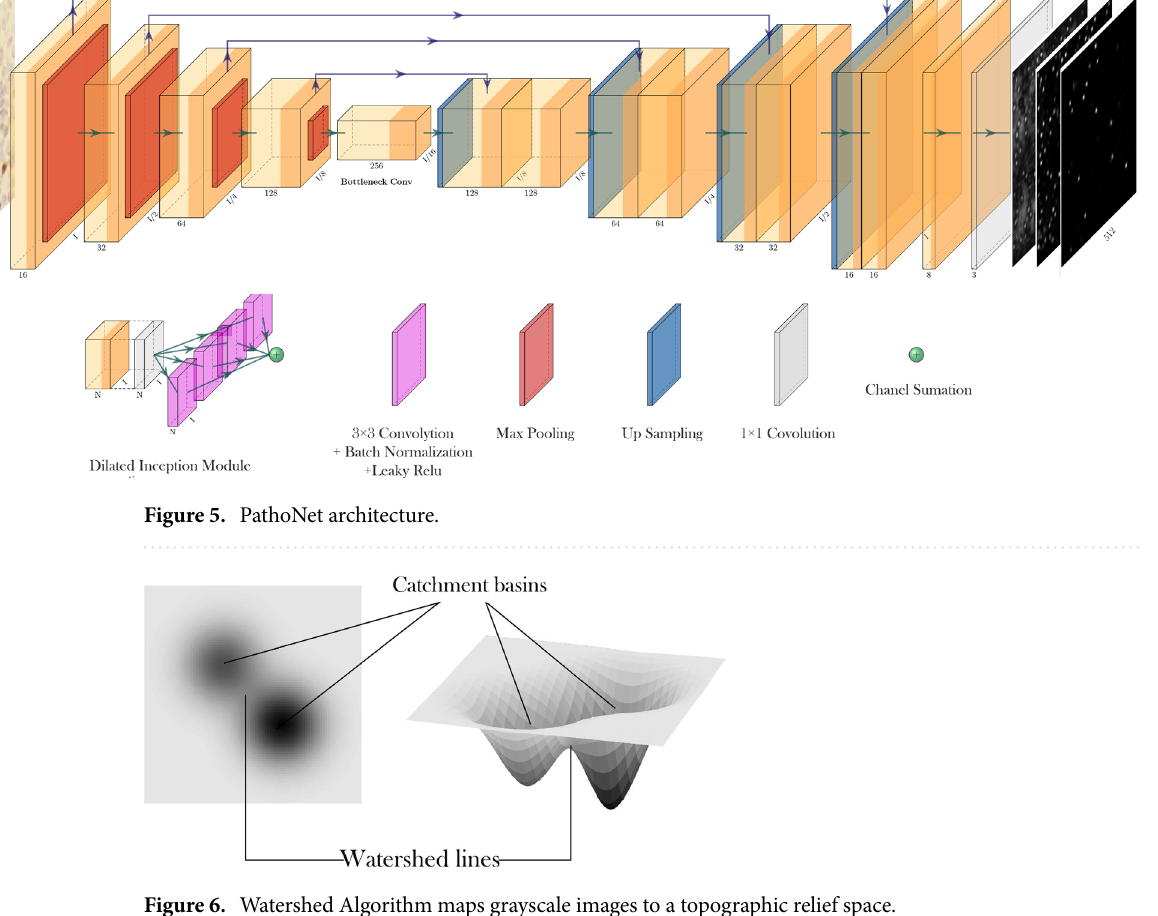
Figure 6. Watershed Algorithm maps grayscale images to a topographic relief